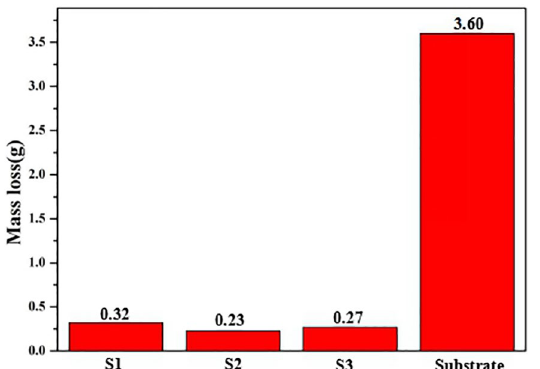
Figure 8. Mass loss of the coatings and substrate.